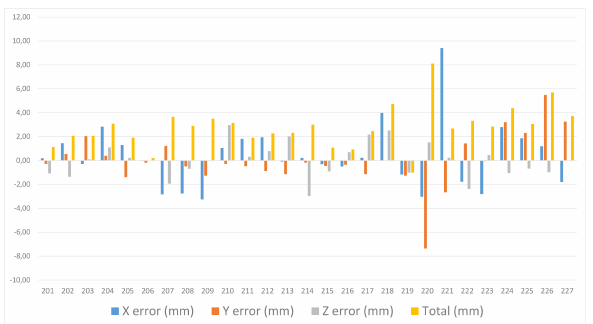
Figure 5. Ground Control Point errors of long wall photogrammetric